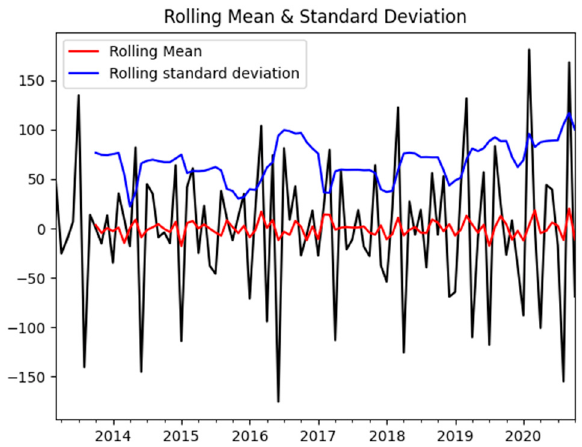
Figure 7. Mean and variance of the sequence of second-order difference. Table 1. Unit root test results of second-order difference data.